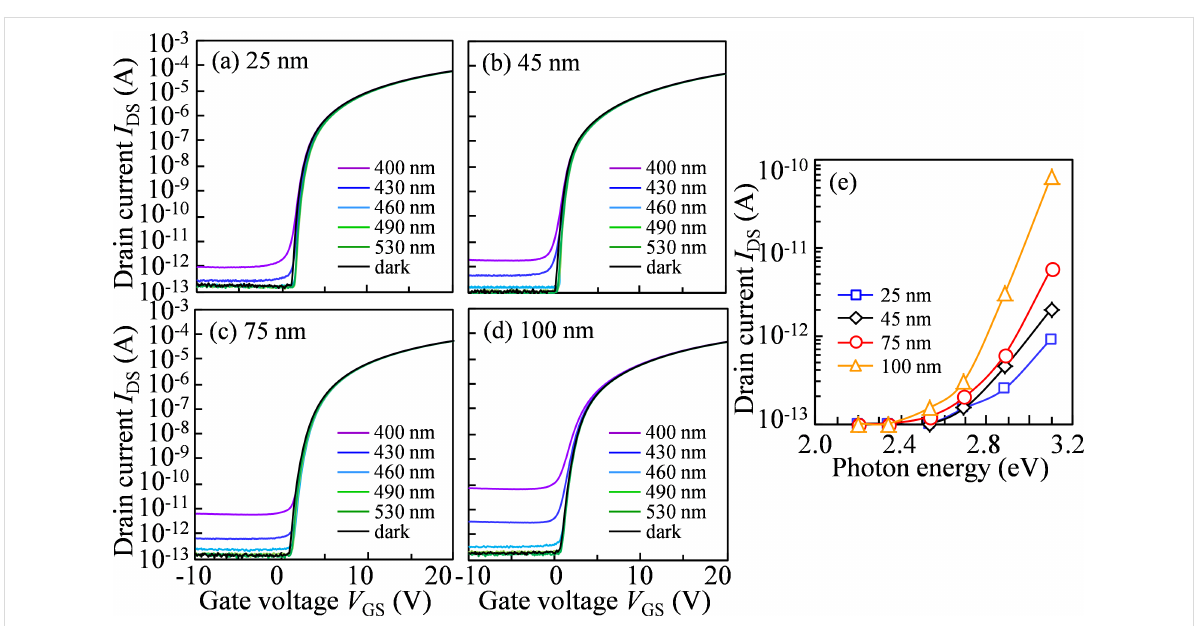
Figure 2: Variation in the transfer characteristics of a-IGZO TFTs with (a) T IGZO = 25, (b) 45, (c) 75, and (d) 100 nm under monochromatic light irradi- ation, and (e) photoleakage current ( V GS = − 10 V and V DS = 10 V) of a-IGZO TFTs with various thicknesses as a function of photon energy of the inci- dent light.